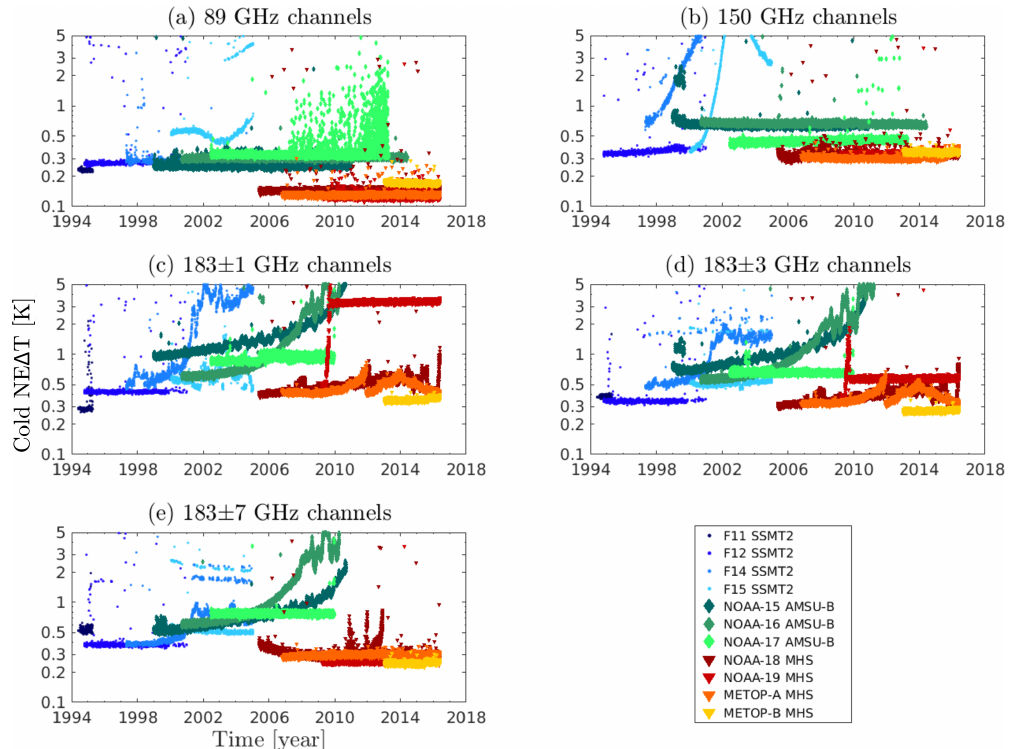
Figure 7. The time evolution of the cold NE (cid:49)T for the five frequency channels.